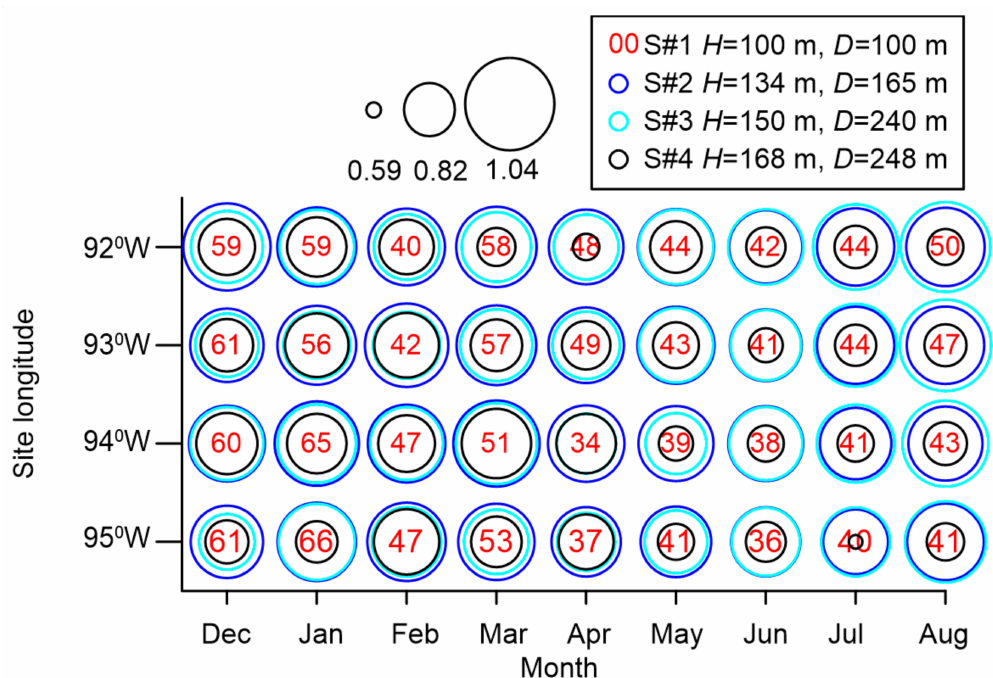
Figure 9. The frequency of shear exponent α > 0.2 at the four transect sites shown by longitude (latitude = 43 ◦ N) and for the four WT scenarios. The center value in red is the frequency in S#1 (%). The colored α S # x α circles show the frequency as a ratio , where S#2 is blue, S#3 is cyan and S#4 is black. The minimum S #1 ratio is 0.59 (site 95 ◦ W, S#4 in July) and the maximum is 1.04 (site 93 ◦ W, S#3 in